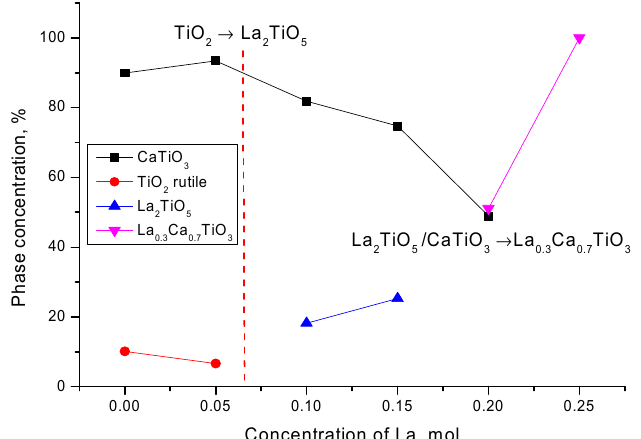
Figure 2. Scheme of phase relations of synthesized samples of CaTiO 3 perovskite-like ceramics doped with lanthanum (La).